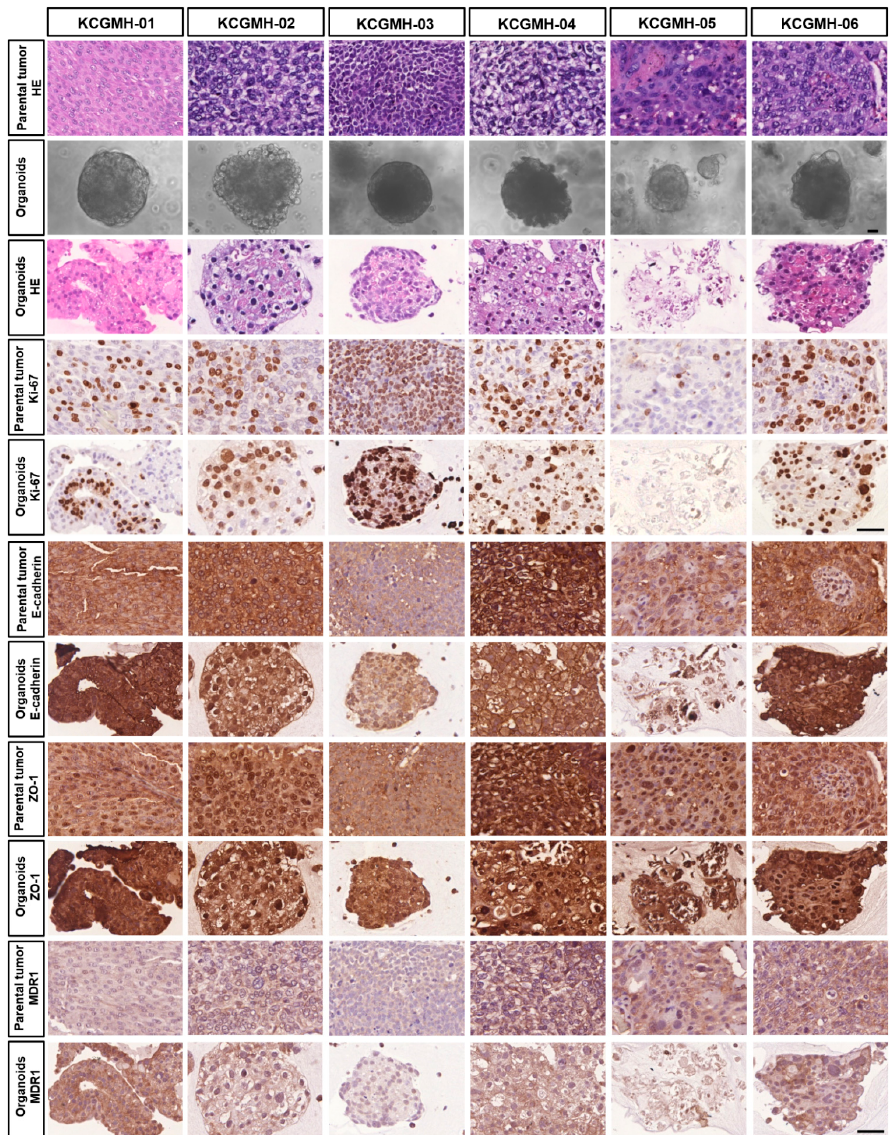
Figure 6. Establishment of Patient-Derived Tumor Organoids of UTUC. Bright-field images of organoids together with H&E staining and immunostaining for the indicated markers of parental tumors and patient-derived organoids. Scale bars indicate 50 μ m.